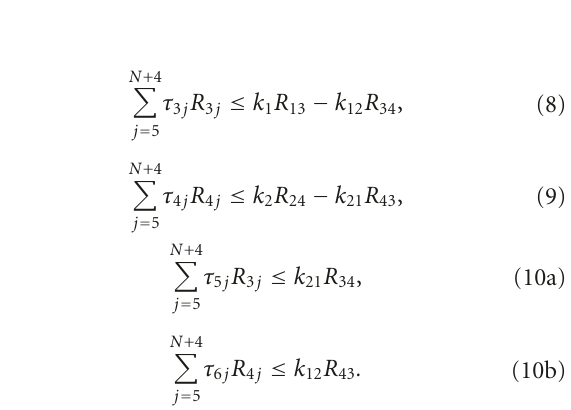
Figure 3: Possible routing paths for an arbitrary mobile within the